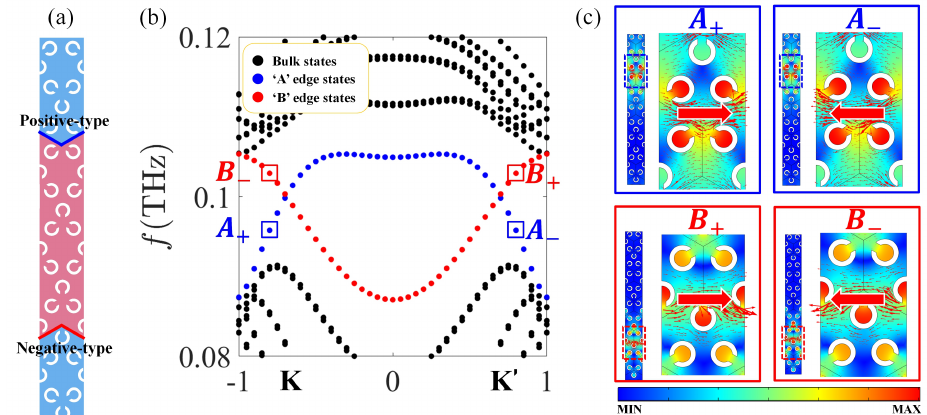
Figure 3. ( a ) Supercell and ( b ) bands of topological insulator with α = − 30 ◦ , θ = 0 ◦ (light red) and α = 30 ◦ , θ = 0 ◦ (light blue). In ( b ), dashed black curves represent the bulk modes and the dashed red/blue curves represent the negative-type/positive-type interfaces edge states. ( c ) The distribution of field for A + , A − , B + , B − in ( b ), and the Poynting vectors are represented by red arrows.